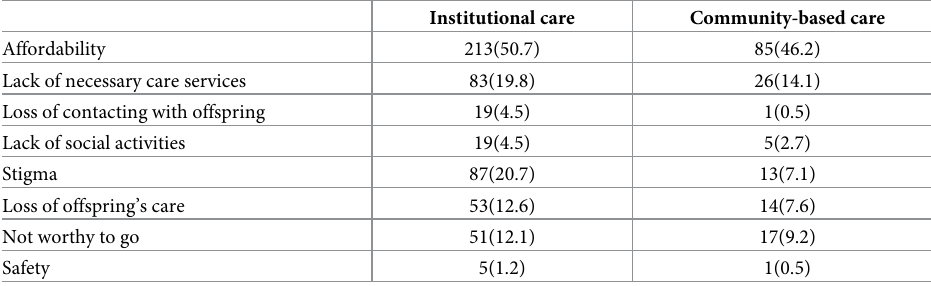
Table 8. Detailed concerns toward institutional and community-based care among the elderly (n =